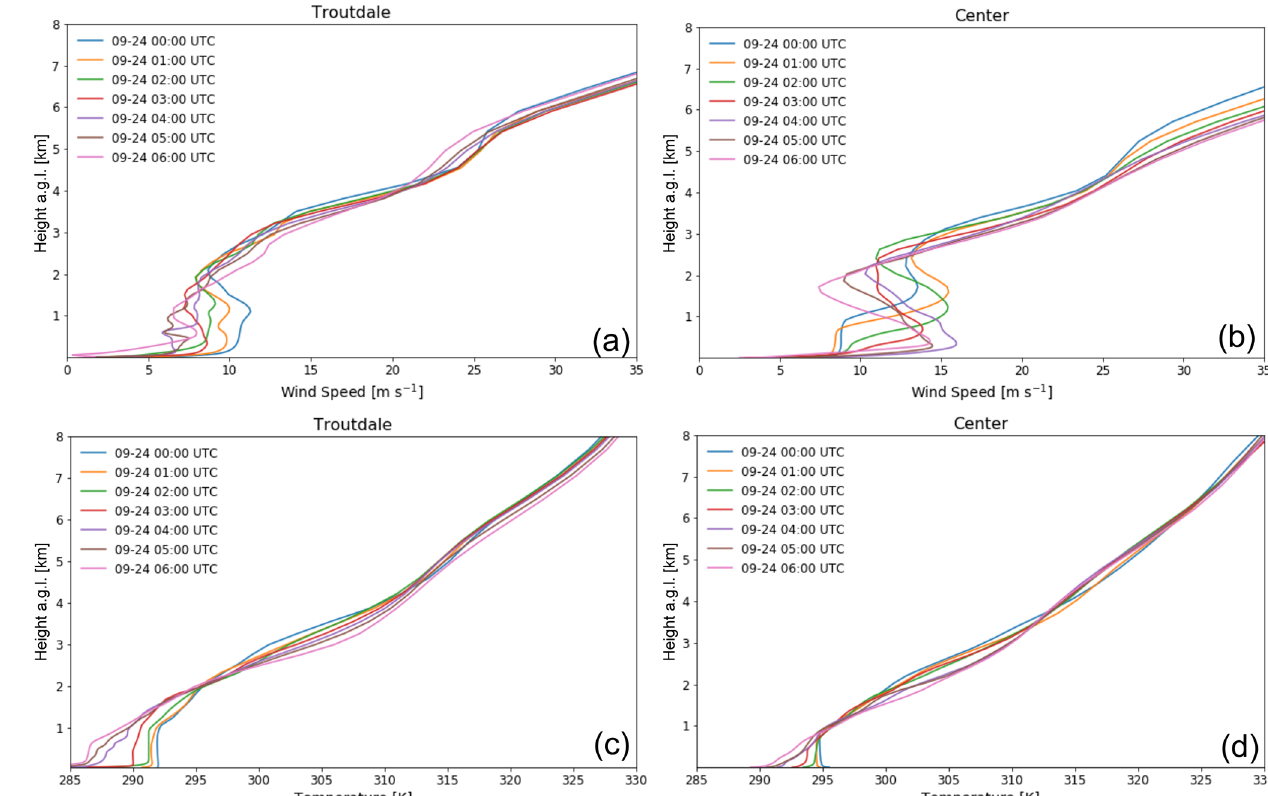
Figure 5. Simulated WRF wind speed (a, b) and potential-temperature profiles (c, d) at Troutdale (a, c) and a location in the center of the modeling domain, east of the Cascade Range, (b, d) during mountain wave activities. Please note that the date format in this figure is month day